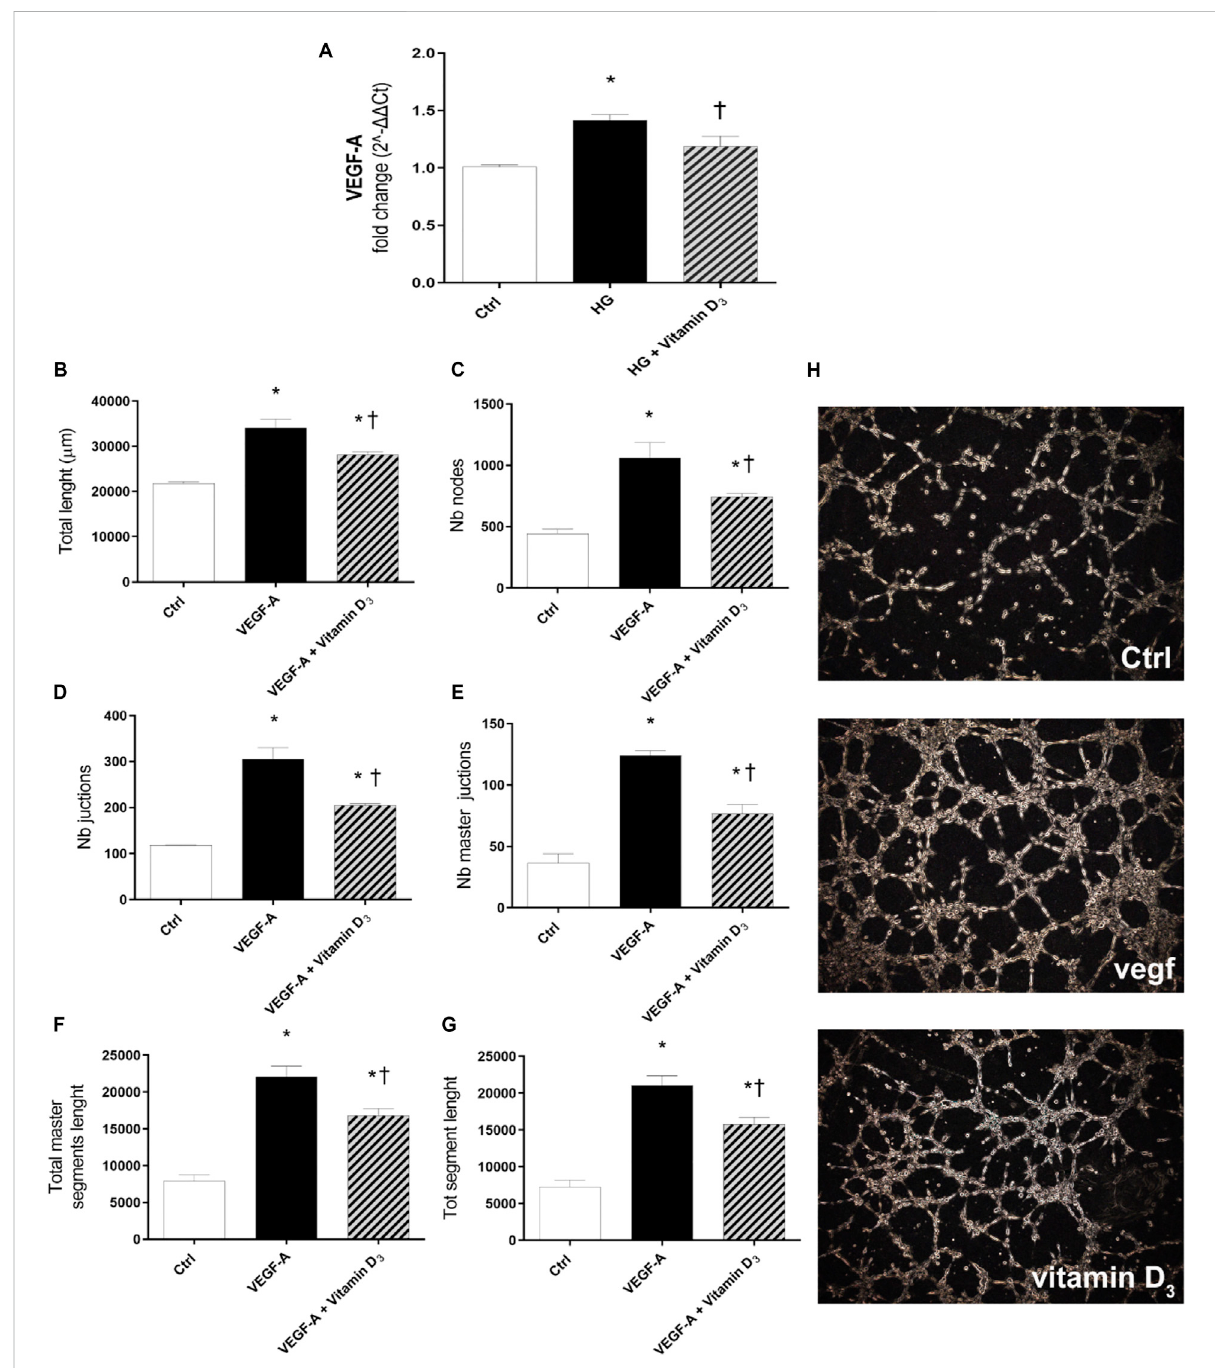
FIGURE 7 EffectofvitaminD 3 onangiogenesis. (A) Real-timePCR;VEGF-AmRNAexpression.HRECswerepre-treatedwithvitaminD 3 (1 µM)for24 hand thenwithorwithoutHG(40 mM)for72 h.VitaminD 3 decreasedmRNAlevelsofVEGF-Aandexertedantiangiogenicactivity. (B – G) Quanti fi cationof total tube length, nb nodes, nb junctions, Nb master junctions, total master segments length and total segment length, was carried out using the Angiogenesis Analyzer tool for ImageJ software. HRECs were treated with 80 ng/ml VEGF-A in presence or absence of vitamin D 3 (1 µM). (H) Representative optical phase-contrast micrographsof tubelike structures (× 40magni fi cation)observed inthe tube formation assays (Matrigel) after 8 h. Values are reported as mean ± SD; n = 4. Data were analyzed by one-way ANOVA and Tukey post-hoc test for multiple comparisons. * p < 0.05 vs. control; † p < 0.05 vs. HG or